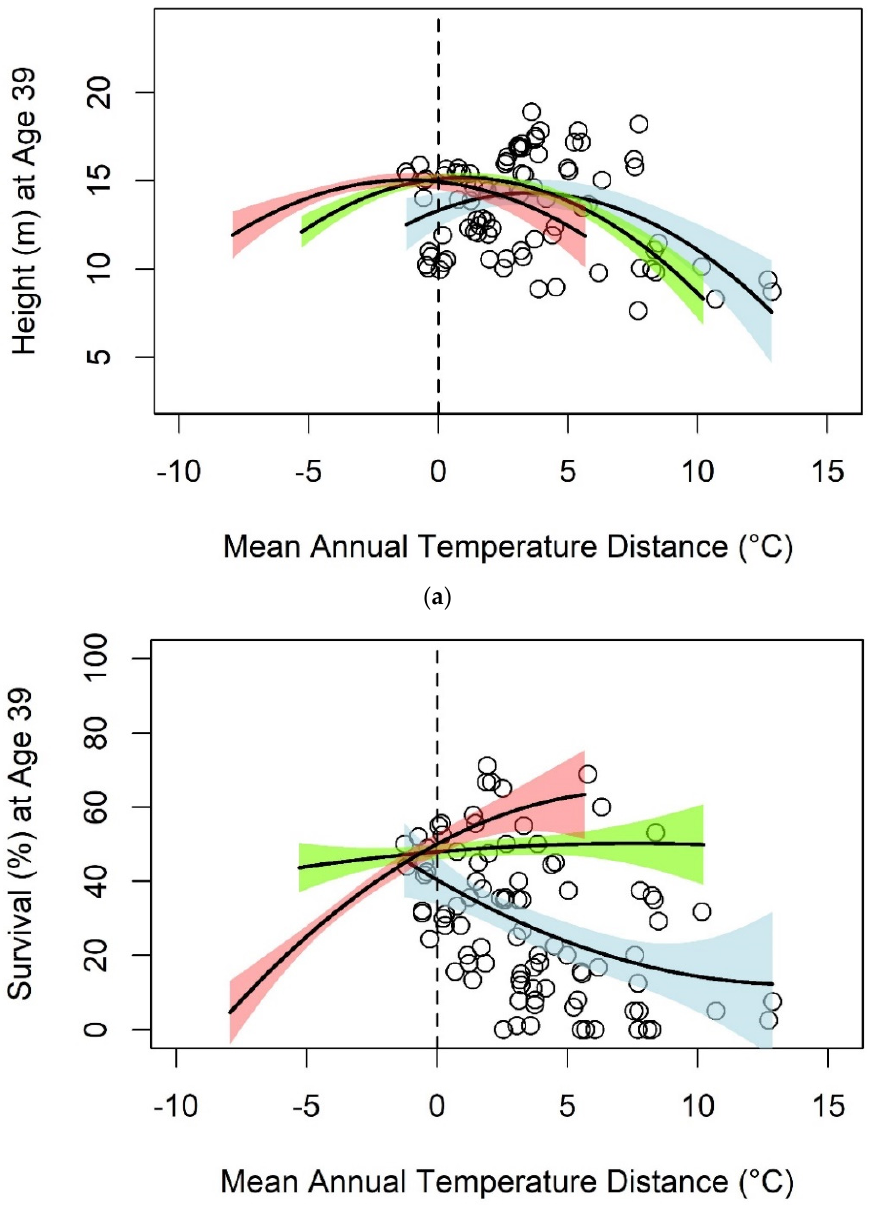
Figure 5. Relationship between mean annual temperature transfer distance and ( a ) height and ( b ) survival of jack pine seed sources at 39 years of age. Separate regression lines and 95% confidence intervals are shown for southern (red), central (green), and northern (blue) seed sources. Data points (black circles) are shown only for northern seed sources. The vertical dashed line indicates local deployment of seed sources (i.e., a transfer distance of zero); points to the right of this line indicate seed transfers to warmer planting sites and vice versa.